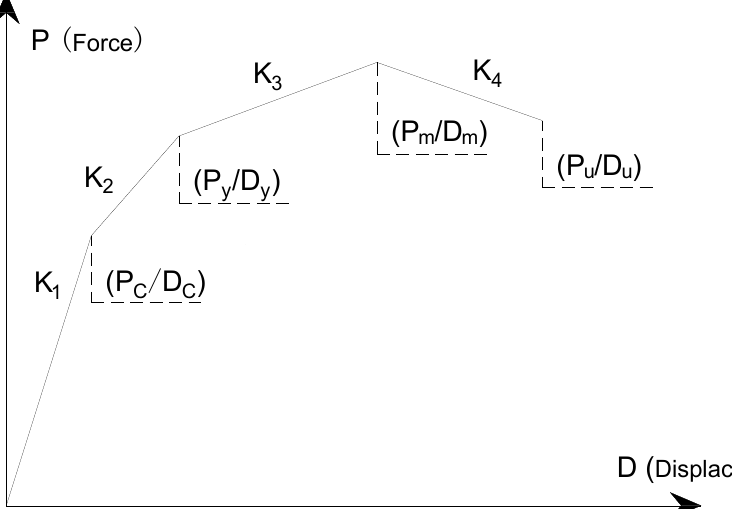
Figure 9. Four-fold skeleton curve model.